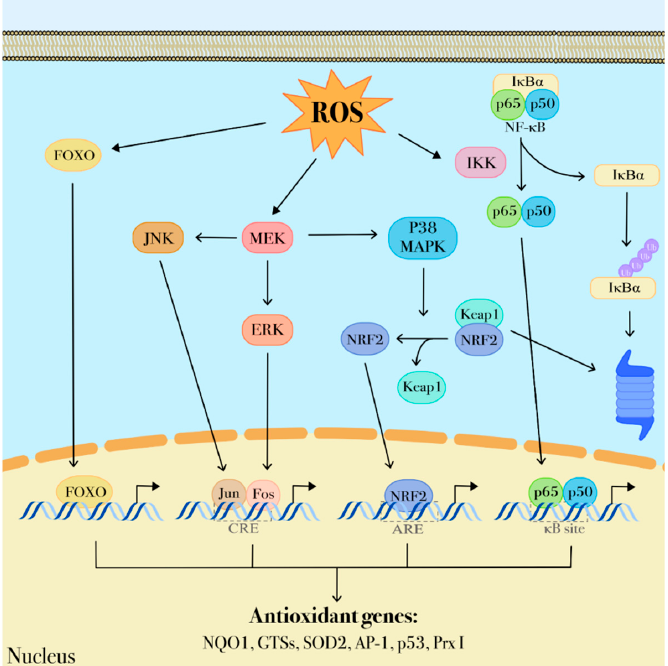
Figure 3. ROS-dependent transduction signaling. ROS are important modulators of